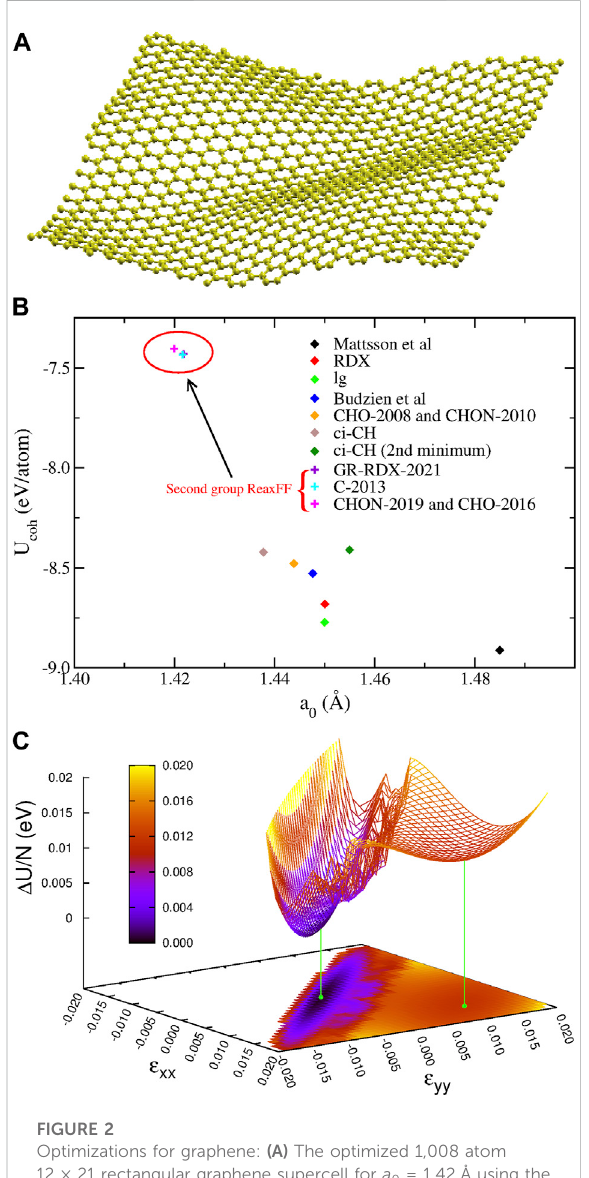
FIGURE 2 Optimizations for graphene: (A) The optimized 1,008 atom 12 × 21 rectangular graphene supercell for a 0 = 1.42 Å using the CHON-2010 potential. (B) Cohesive energy U coh as a function of bond length a 0 for graphene for the different ReaxFF. (C) The potential energysurface U ( ε xx , ε yy )ofgraphenederivedfromci-CH potential. The two minima are shown with the green points and lines.